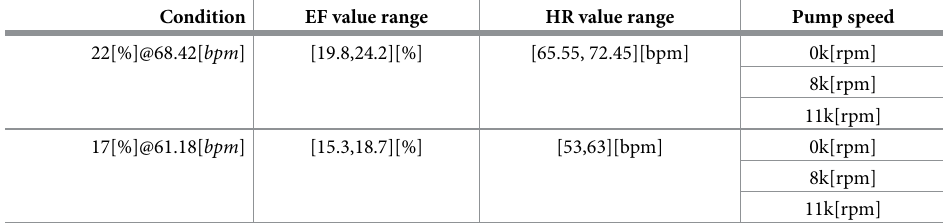
Table 5. The six validation points used for the UQ